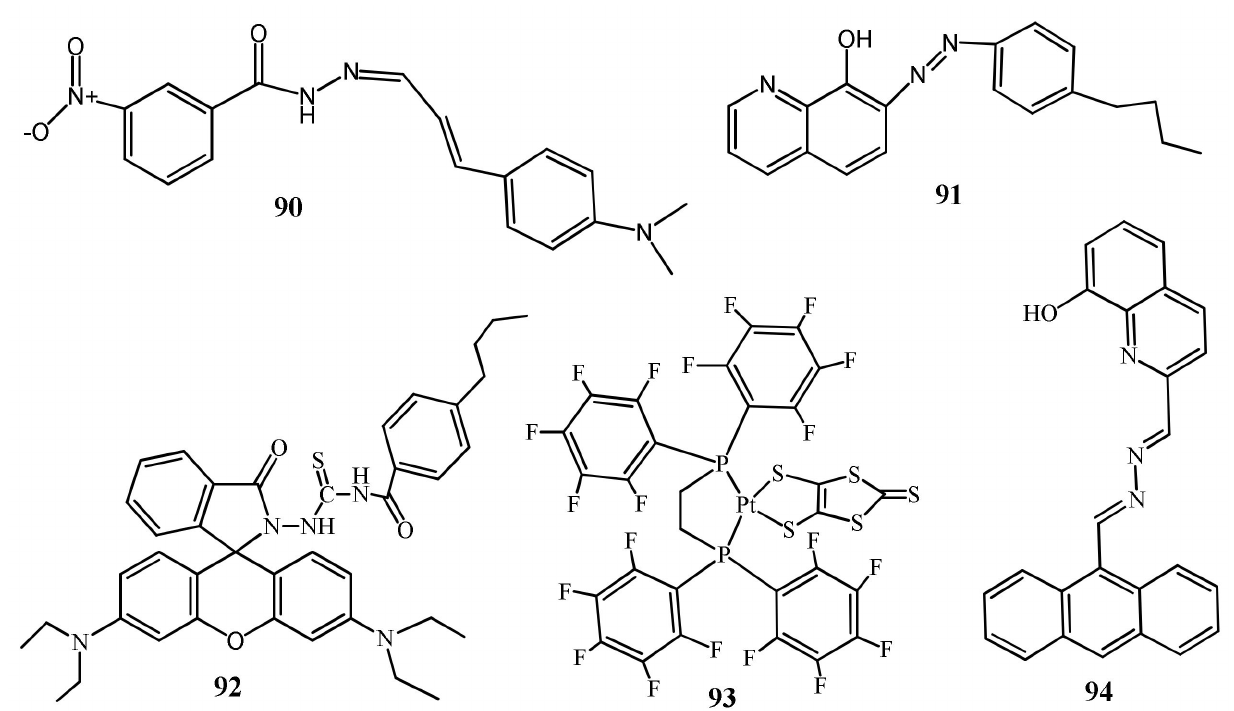
Figure 30. Molecular structures of the sensors 90 to 94